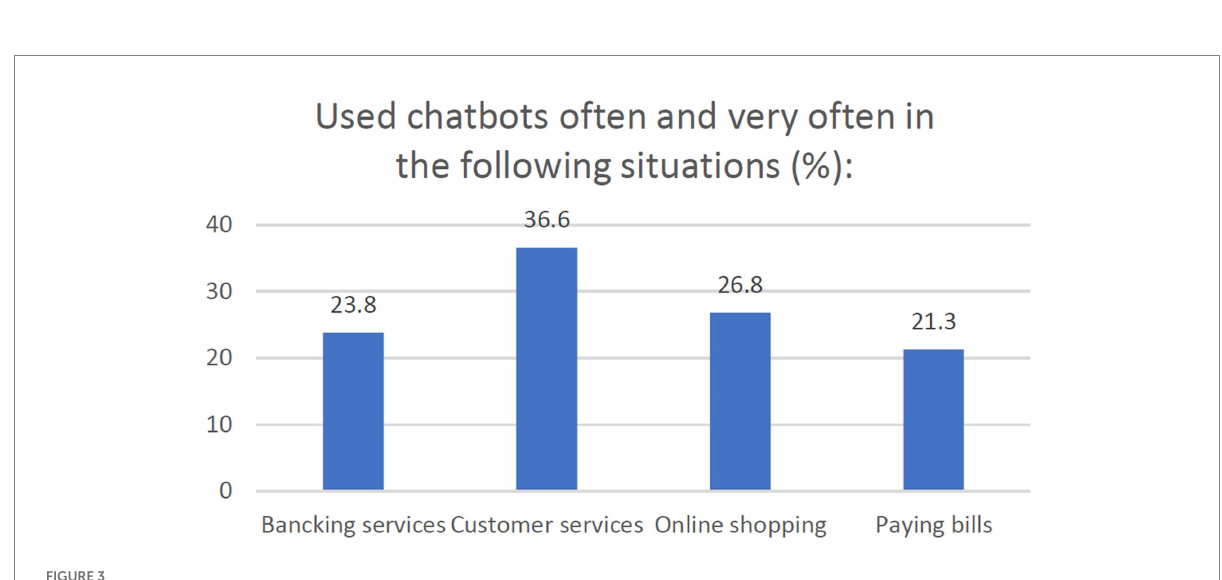
FIGURE 3 The use of chatbots for certain